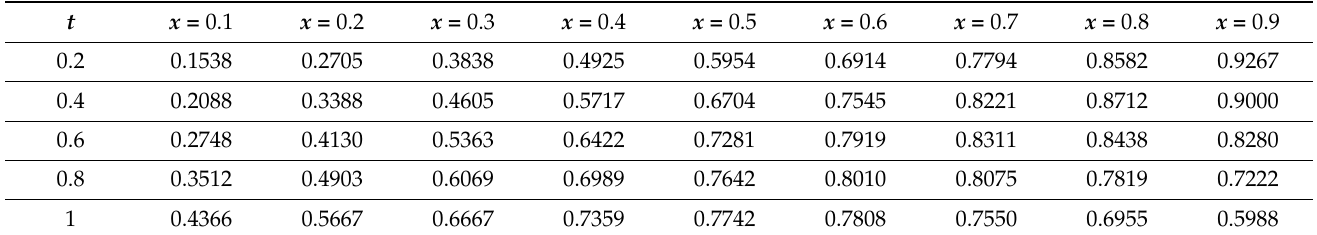
Table 2. Numerical values of moisture content U ( x , t ) .